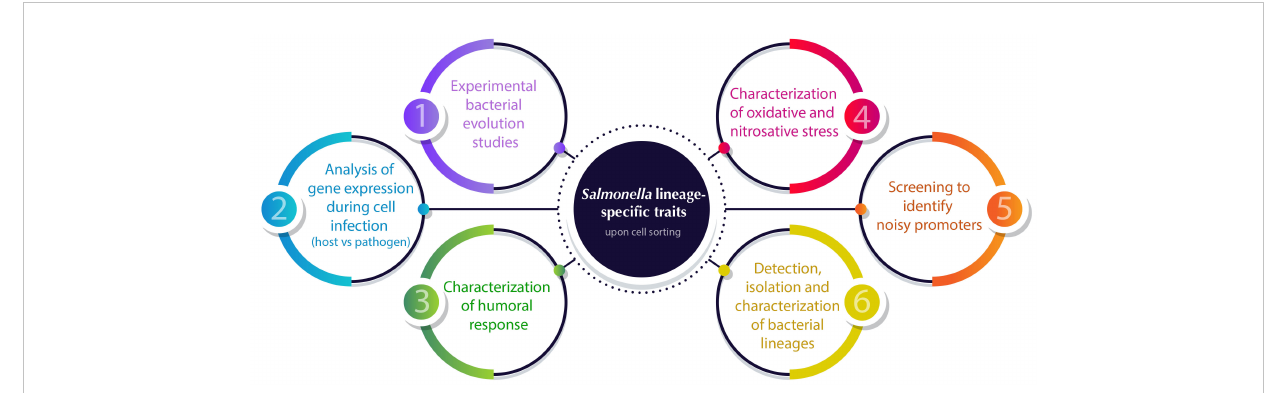
FIGURE 2 Overview of cell sorting applications for analyzing Salmonella lineage-speci fi c traits to solve the structure of bacterial populations. Numbers indicate the sections in which the applications are described in